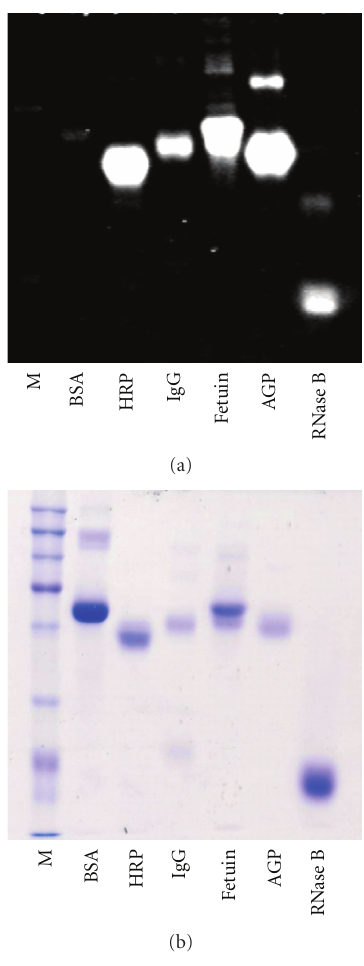
Figure 3: (a) LRSH staining of various glycoproteins. (b) Post- stained with Coomassie blue. Each lane was loaded with two μ g of protein. M represents standard protein molecular weight markers. Bovine serum albumin (nonglycoprotein), horseradish peroxidase, immunoglobin G, α -acid glycoprotein, and ribonuclease B are denoted by BSA, HRP, IgG, AGP, and RNase B.